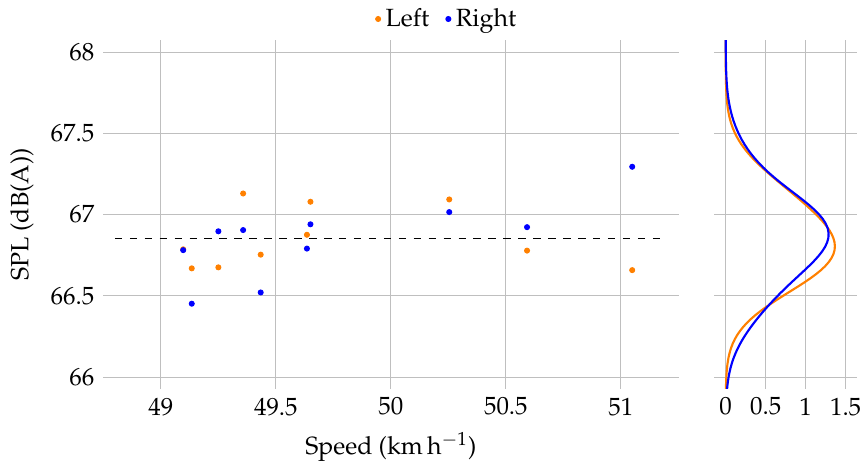
Figure 16. SPL and their distributions at Point P-P’ for idle runs at approximately 50kmh − 1 for microphones on right and left